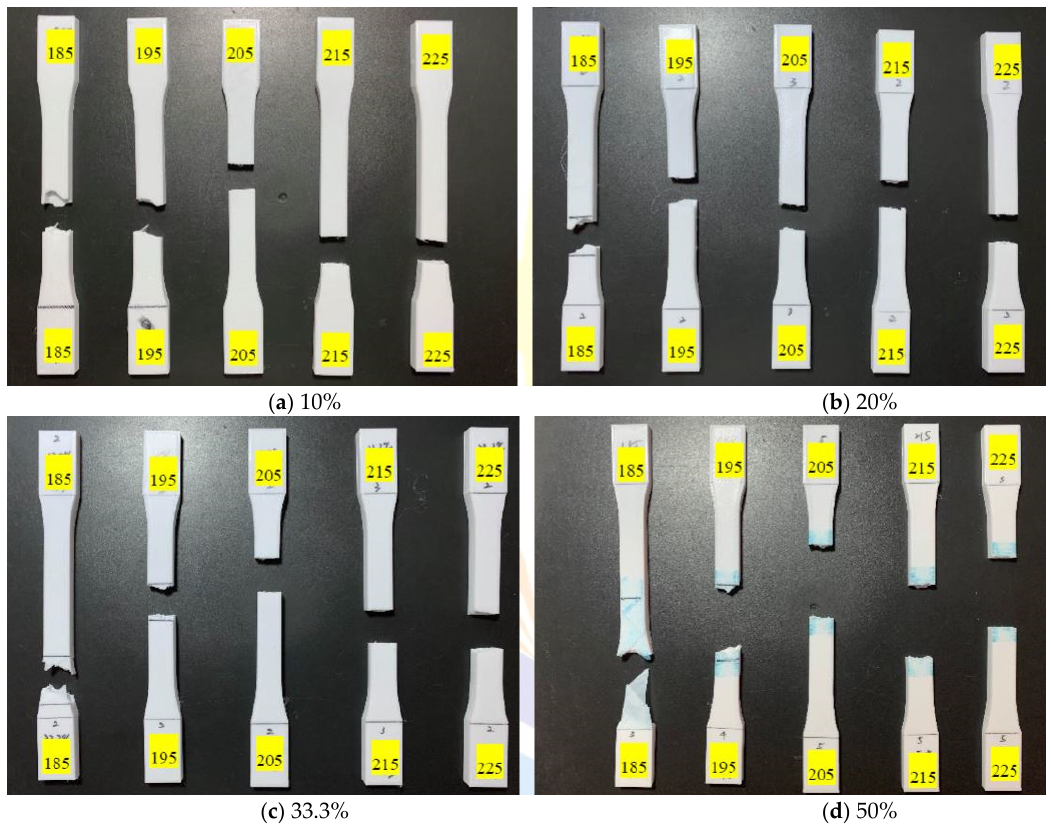
Figure 7. Tensile test specimens with different filling percentages ( a ) 10%, ( b ) 20%, ( c ) 33.3%, and ( d ) 50% under various printing temperature conditions before UV curing.